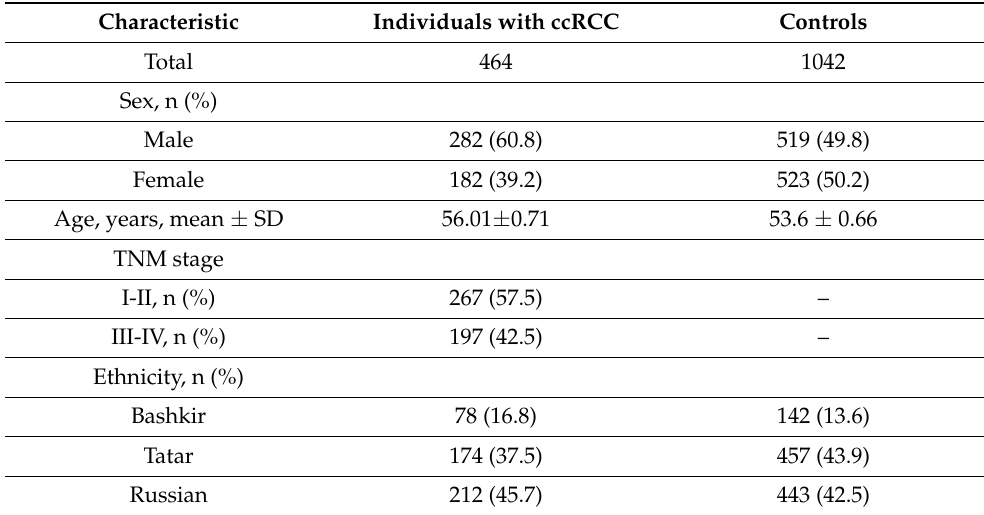
Table 1. Characteristics of study population.